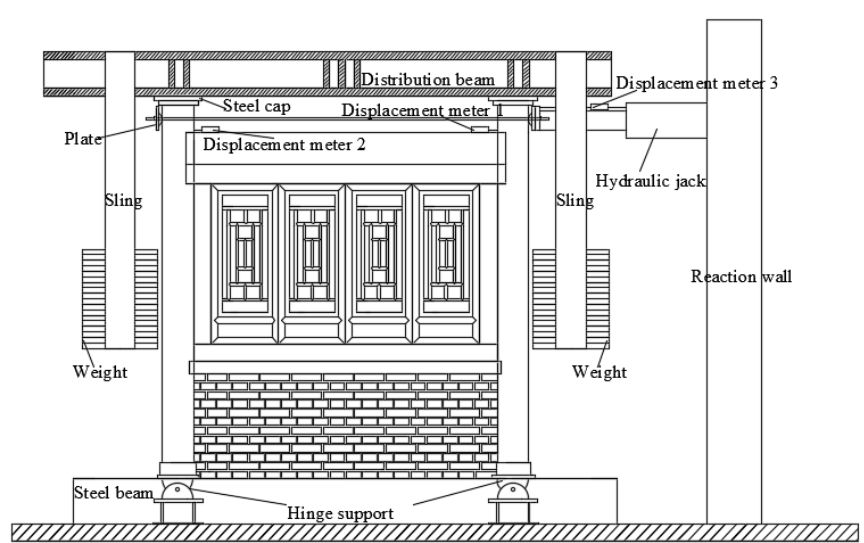
Figure 8. Schematic diagram of the loading equipment.